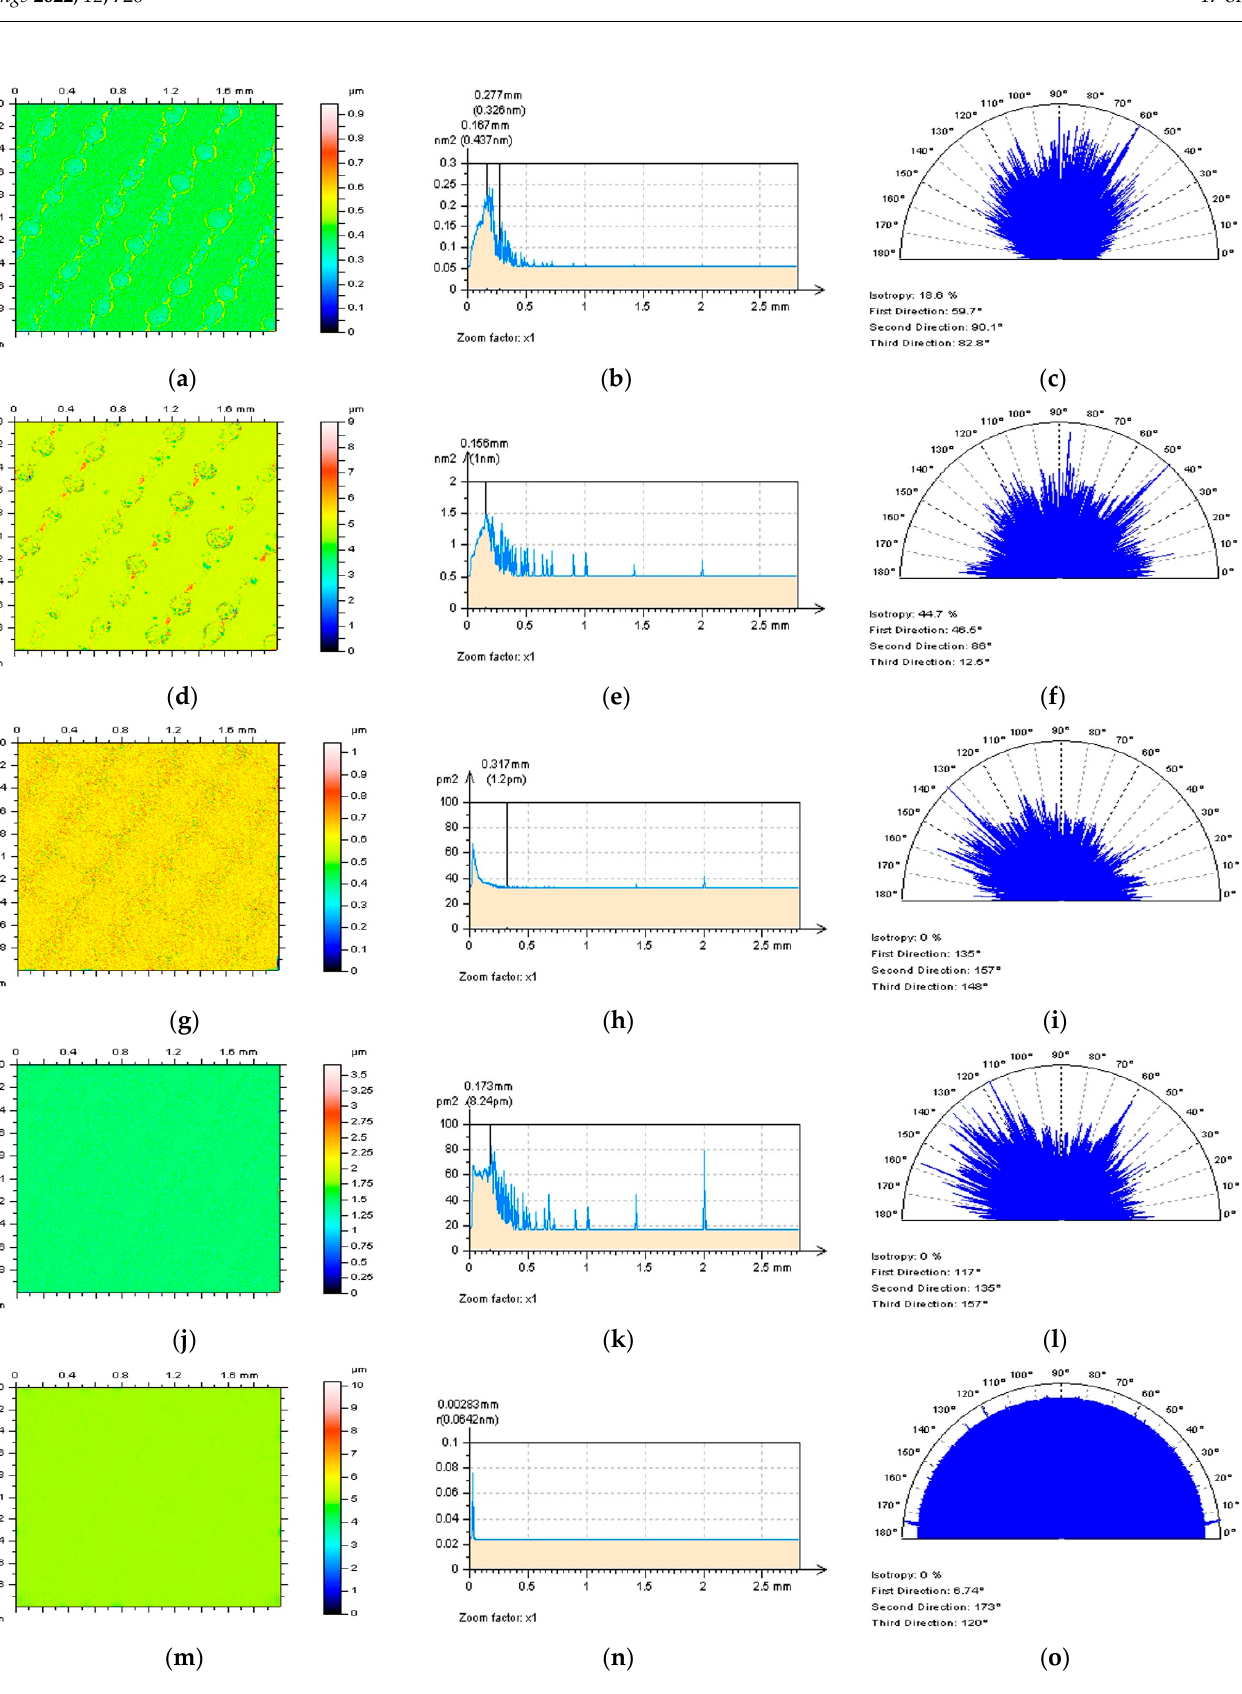
Figure 9. Analysis of a HFNS (left column), their PSDs (middle) and TDs (right column) received from a 30° left rotated laser ‐ textured surface by application of the following filtering method: GF